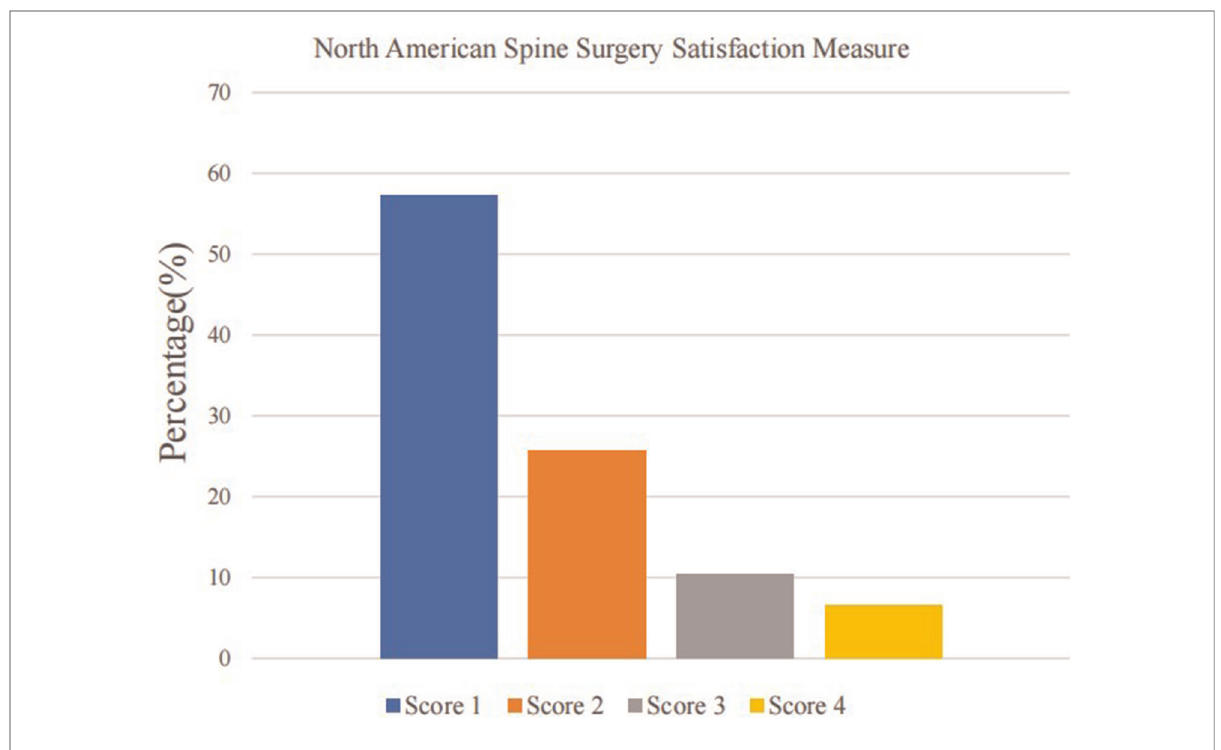
FIGURE 2 North American Spine Surgery Satisfaction